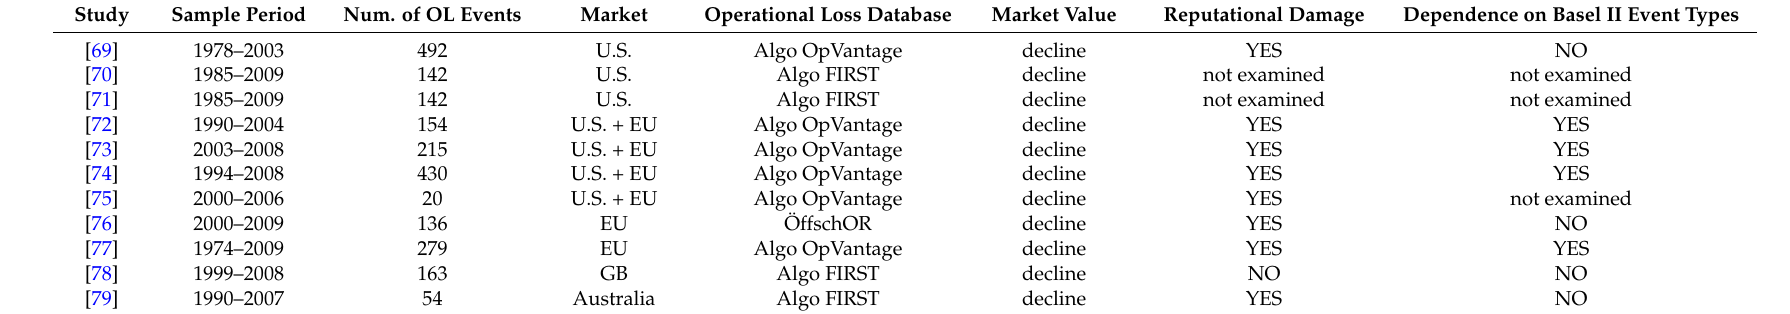
Table 2. Empirical studies analysing the impact of operational loss events on announcing firm´s market value and